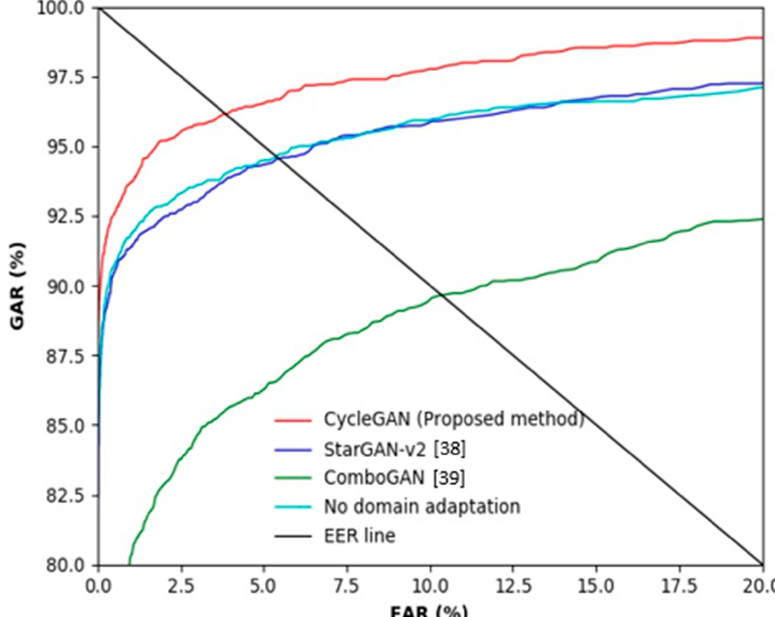
Figure 9. ROC curves of finger-vein recognition by the proposed method and other methods in case of training with HKPolyU-DB and testing with SDUMLA-HMT-DB.